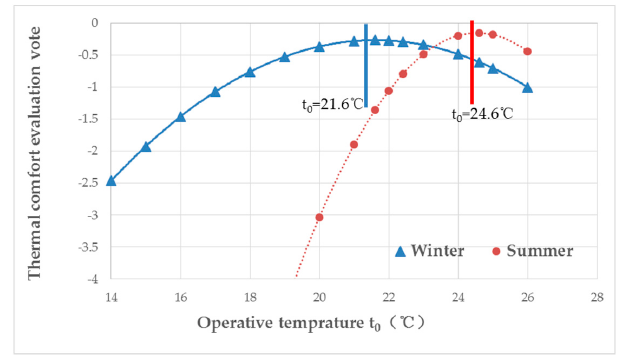
Figure 9. Non-dimensional function curve of thermal comfort (Winter/Summer).